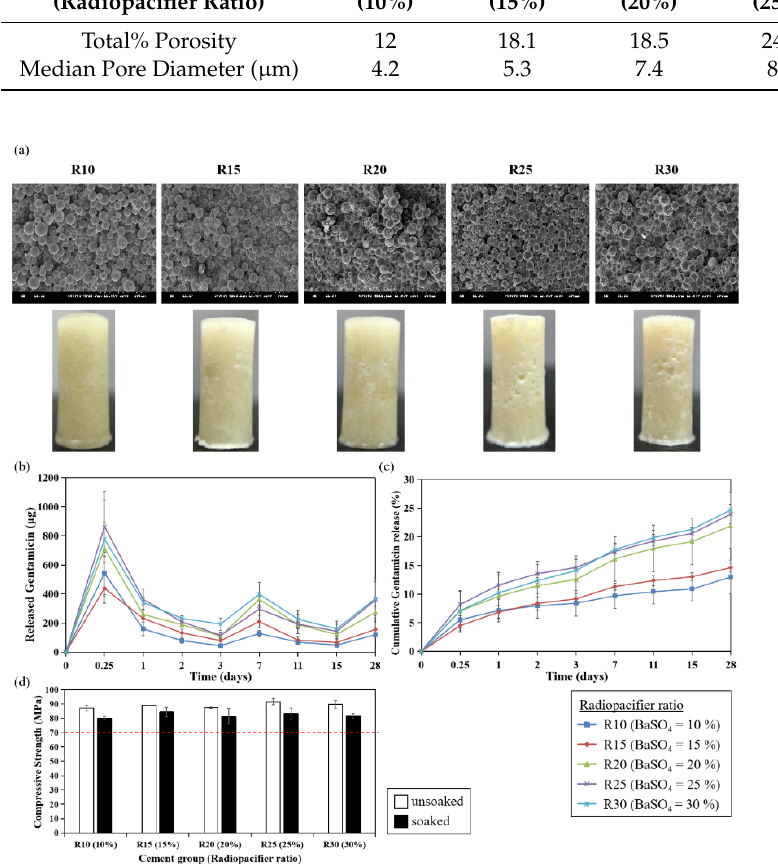
Figure 5. Effects of radiopacifier ratio on antibiotics elution and compressive strength of PMMA bone cement. ( a ) SEM images and morphology of PMMA cement. ( b ) Gentamicin elution profile. ( c ) Cumulative gentamicin release percentage. ( d ) Compressive strength. White bar: unsoaked cement; black bar: PBS-soaked cement. The dashed line indicates the ISO standard for compressive strength (70 MPa).